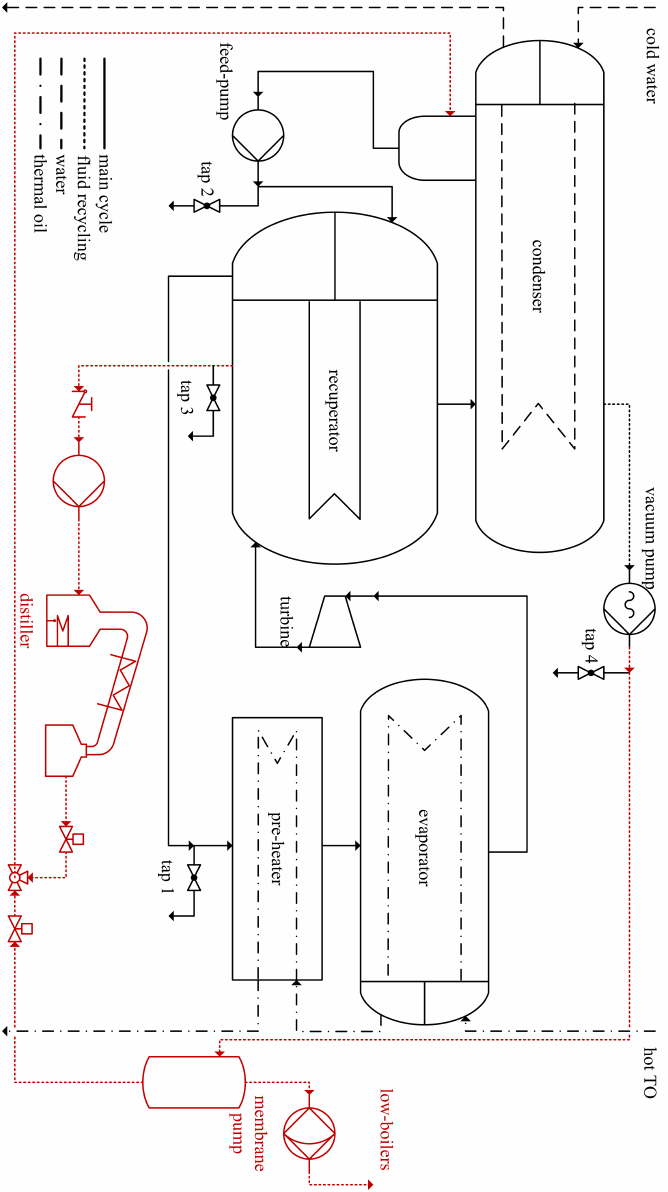
Figure 9. Cycle scheme including sample taps and all design modifications